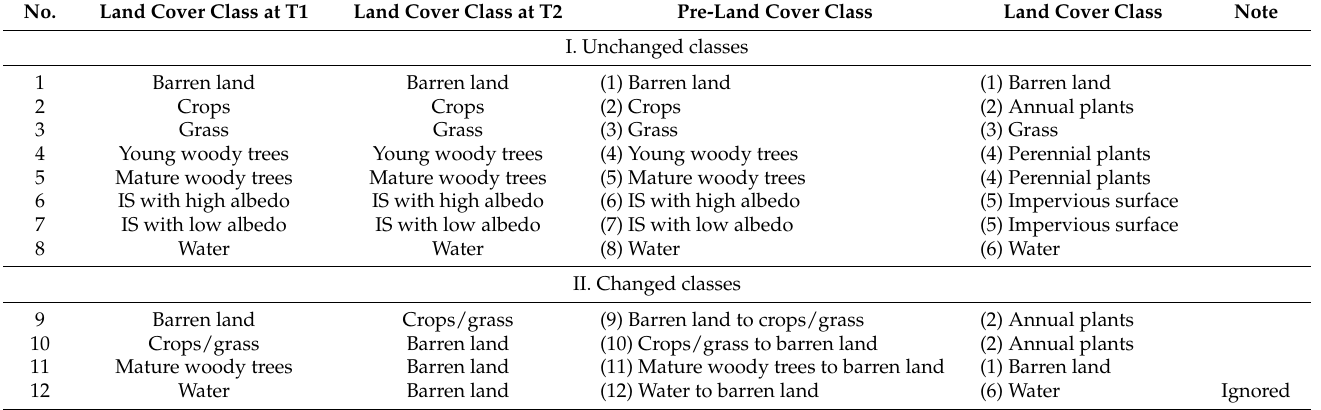
Table 1. Pre-land cover and land cover classification scheme.